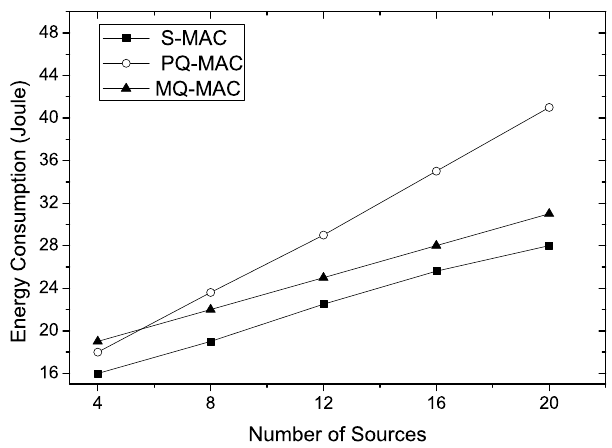
Figure 14. Energy consumption varying number of sources.